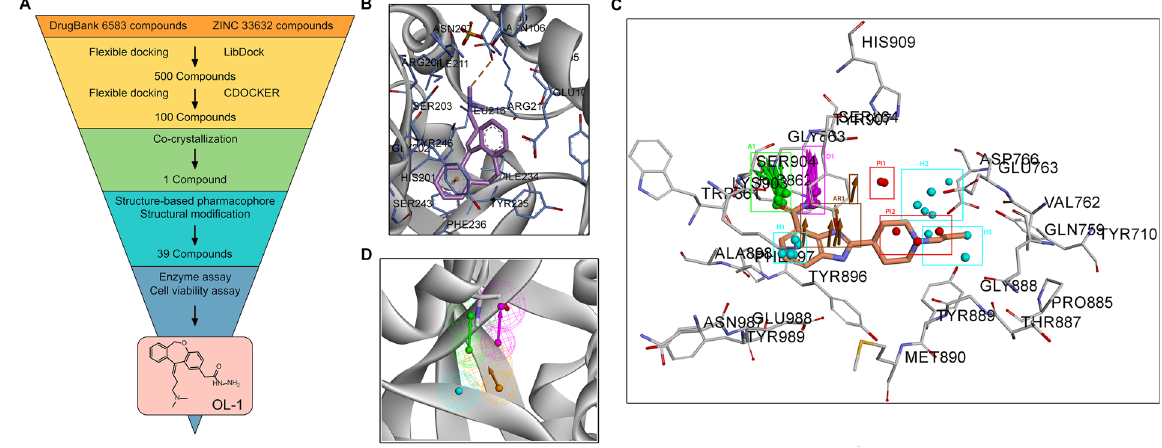
Figure 2. Crystal structure, pharmacophore models construction and molecular docking of PARP1 inhibitors. ( A ) Virtual screening schematic model for the discovery process of novel PARP1 inhibitors. ( B ) Candidate PARP1 inhibitor PA-10 bind to the NAD + binding site. ( C ) Comprehensive structure-based pharmacophore features of PARP inhibitors. ( D ) The four common structure-based pharmacophore model.